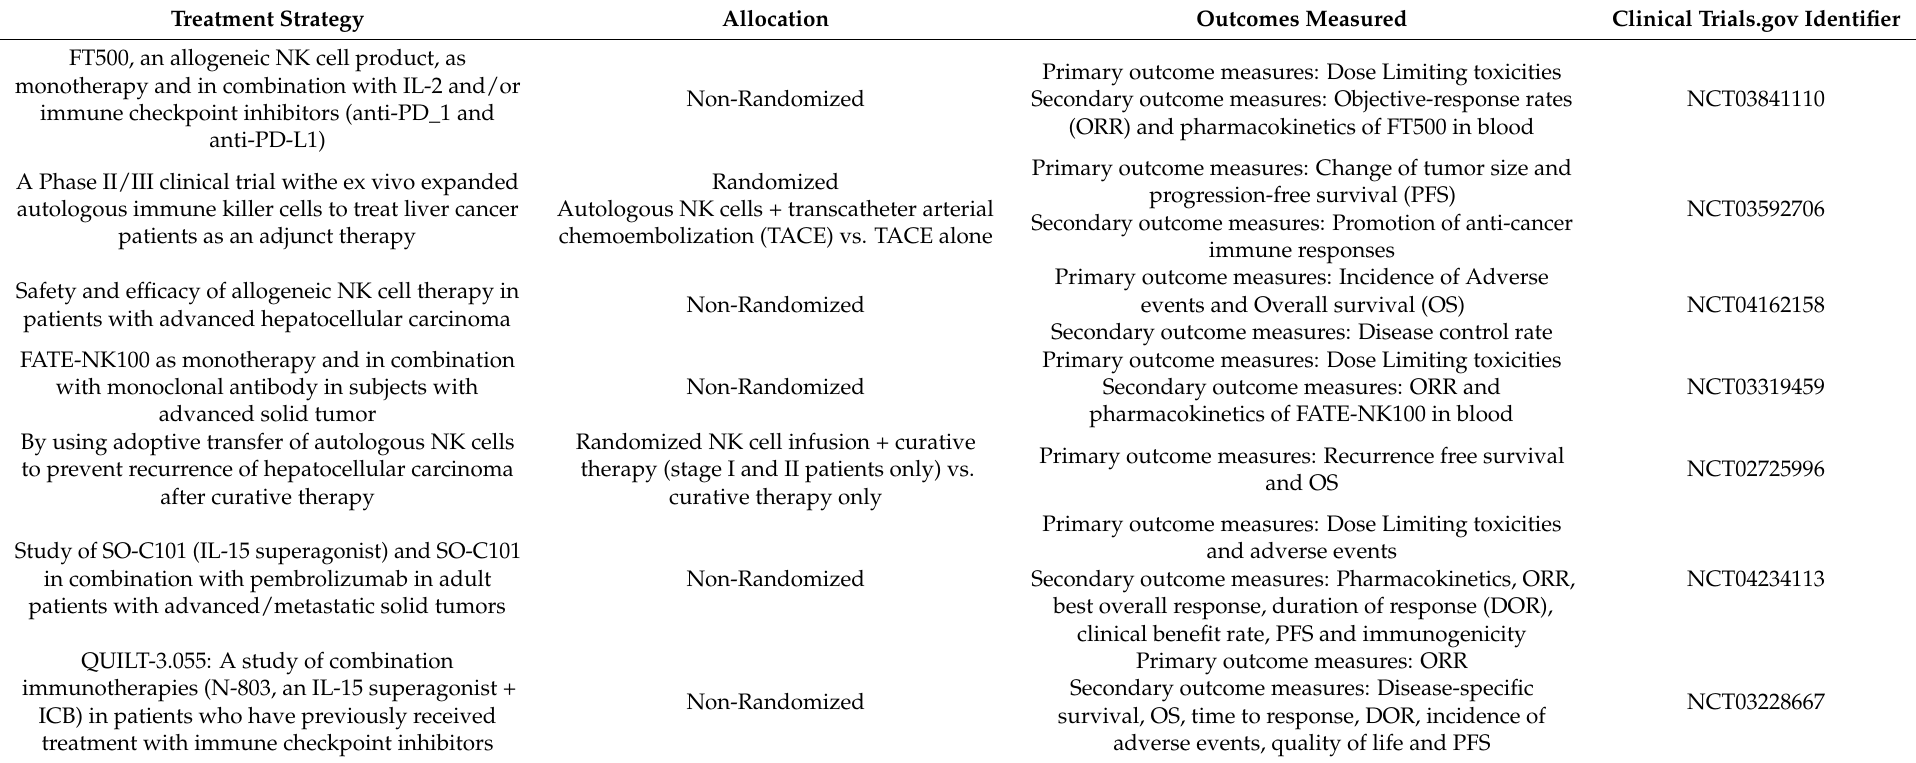
Table 3. Strategies currently evaluated in clinical trials, consisting of taking advantage of NK cell-based immunotherapies in